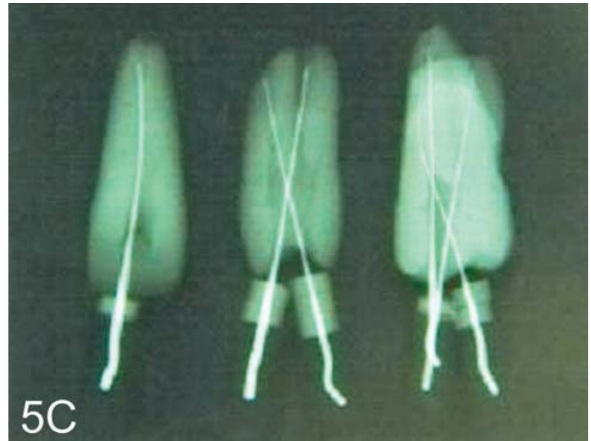
FIGURE 5C- Radiographic image of root canal